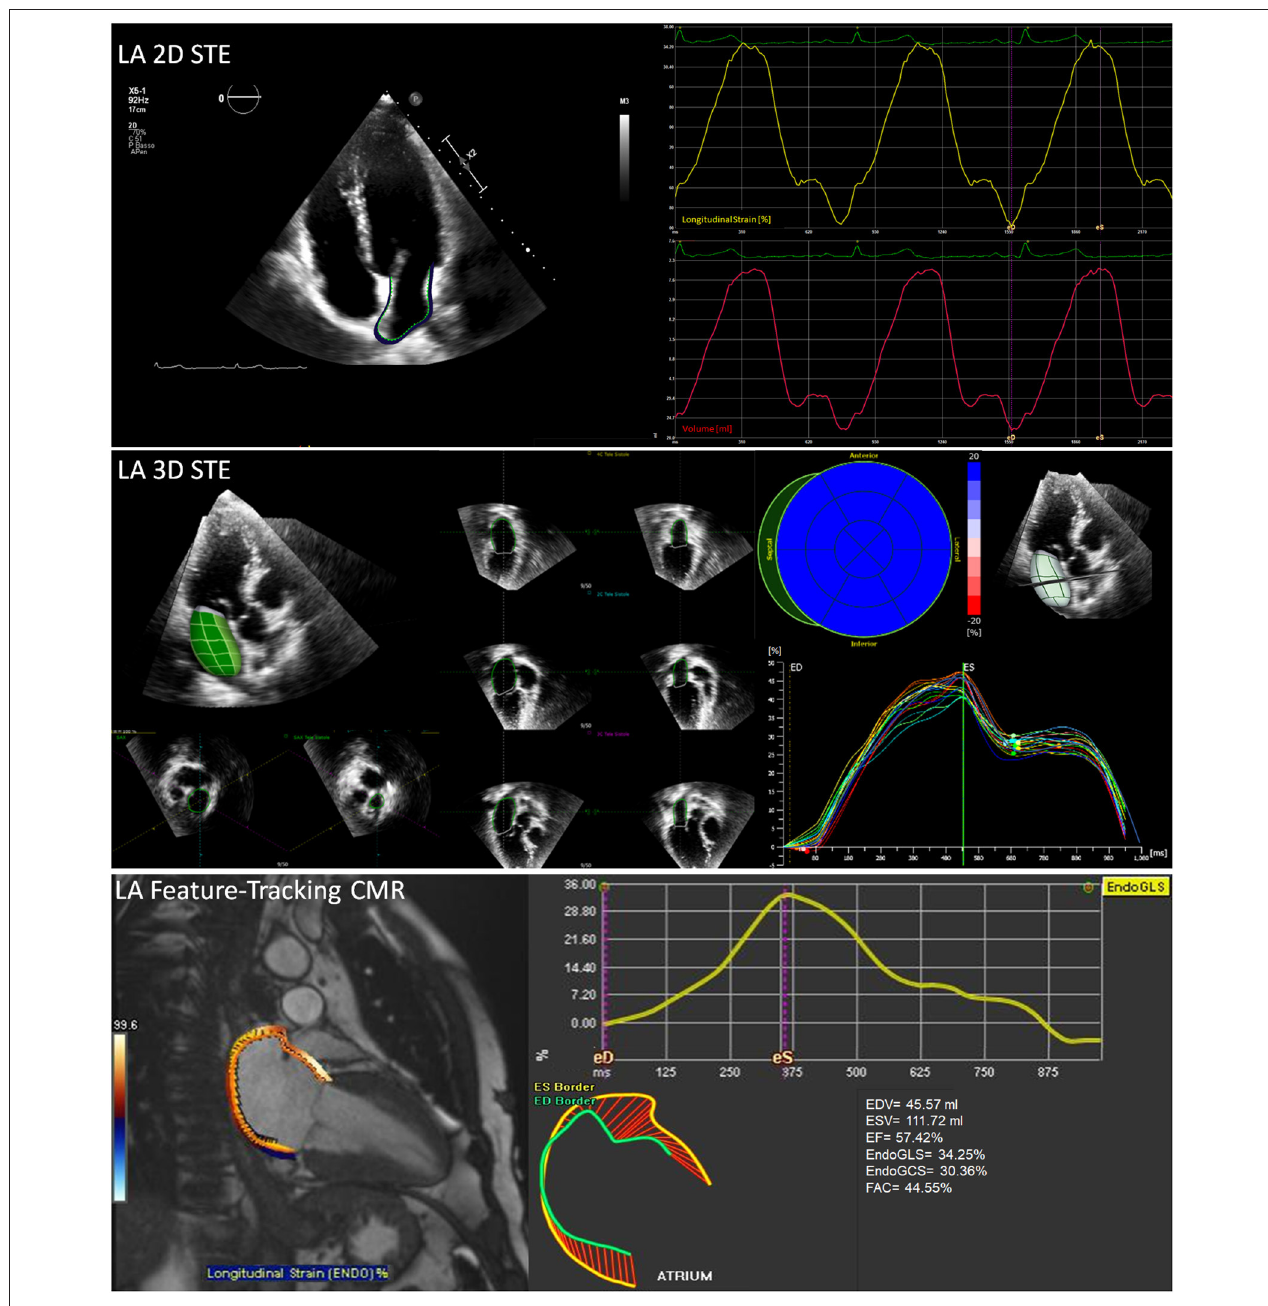
FIGURE 2 | Non-invasive assessment of LA mechanics. Some elaboration and output examples of the mostly used imaging techniques are reported: (top) 2D speckle tracking echocardiography with atrial border contouring (top left), average longitudinal endocardial strain and volume changes (top right) ; (middle) 3D speckle tracking echocardiography with 3D LA volume reconstruction (middle left) and multi-segment longitudinal endocardial strain; (bottom) feature-tracking cardiovascular magnetic resonance (CMR) with atrial border contouring (left) and average longitudinal endocardial strain (bottom right) . Abbreviations as in the